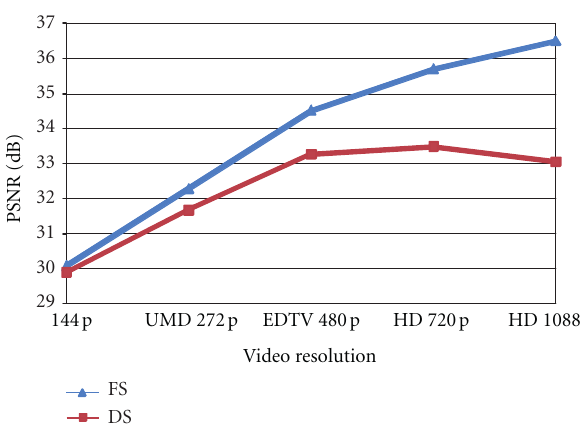
Figure 1: Average PSNR curves of DS and